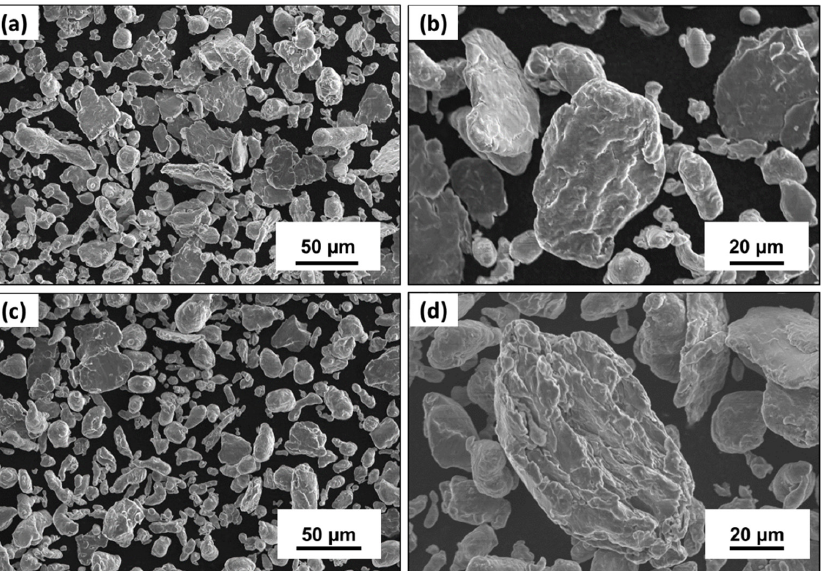
Figure 4. SEM micrographs for Al-3Mg 4 h cryomilled sample showing ( a ) particle morphology and ( b ) shearing and fracture on a single cryomilled particle. The comparative SEM micrographs for 6 h cryomilled sample’s ( c ) morphology and ( d ) fracture surface.